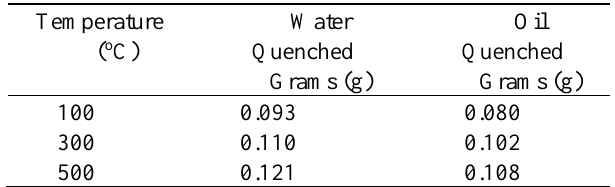
Weight loss of water and oil quenched samples at different temperatures